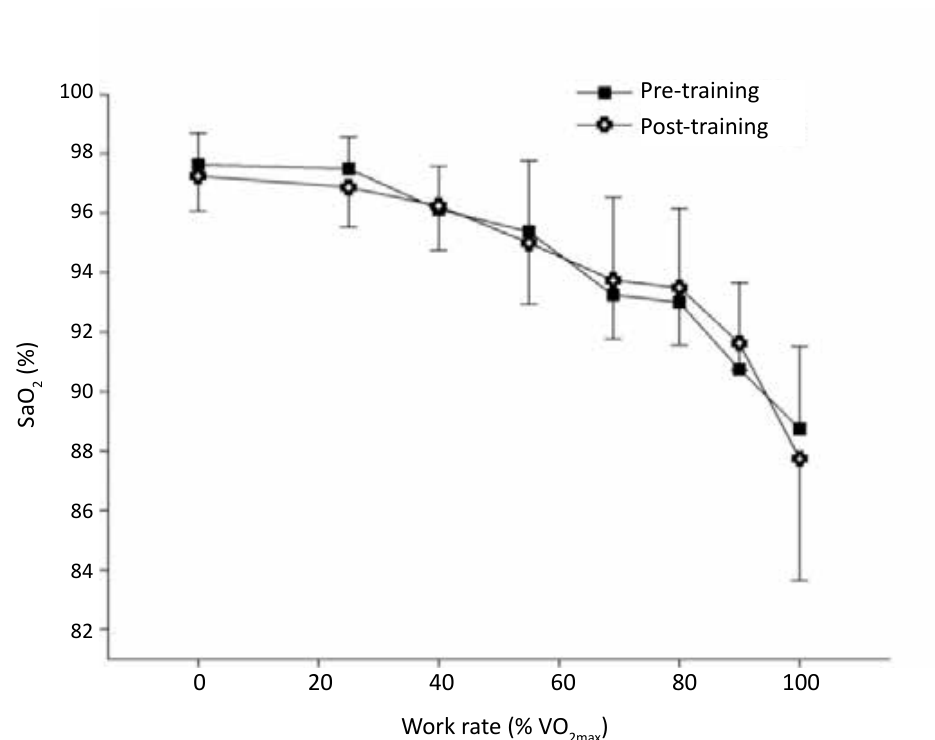
Figure 2. Mean values for the changes in the percent of oxyhemoglobin saturation (SaO relative work rate during incremental treadmill test before (pre) and after (post) the 6-week training